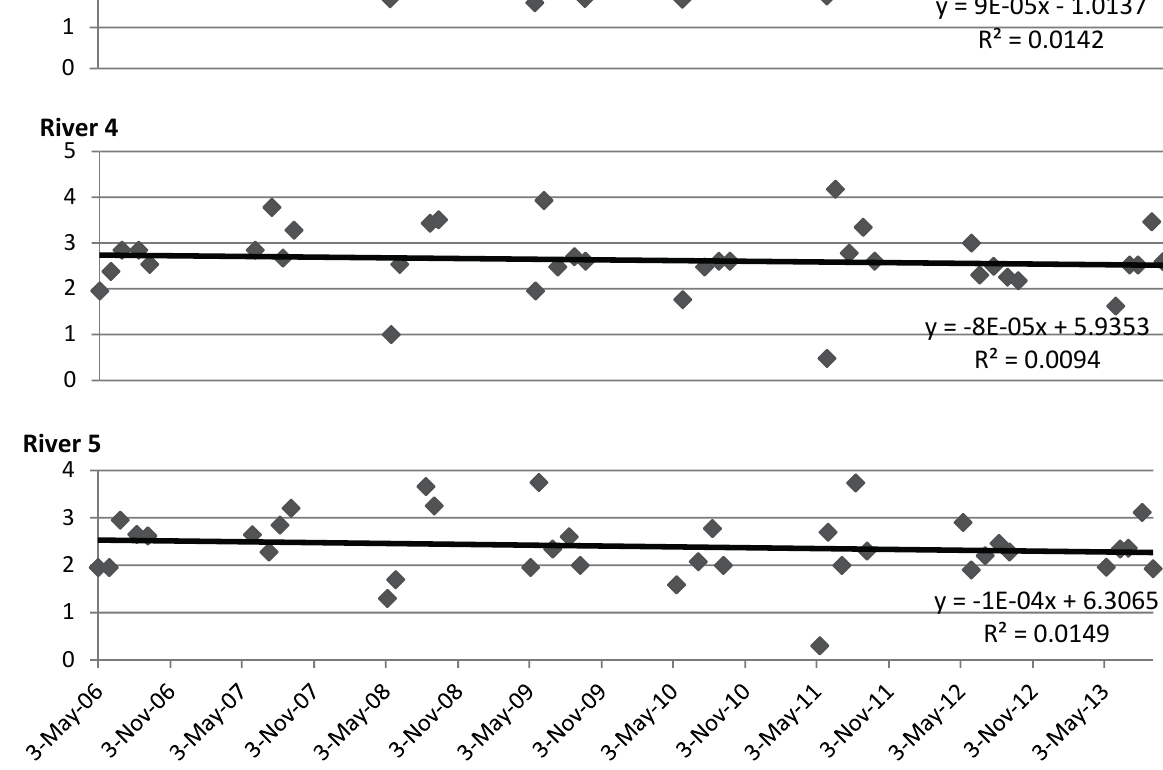
Figure 2. Monthly samples of fecal coliforms or E. coli (log 10 cfu/100 mL) sampled by the municipality in the irrigation period (May to